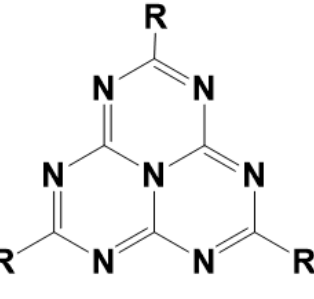
Figure 1. Synthetic Scheme of the porphyrin-heptazine dyad 1.